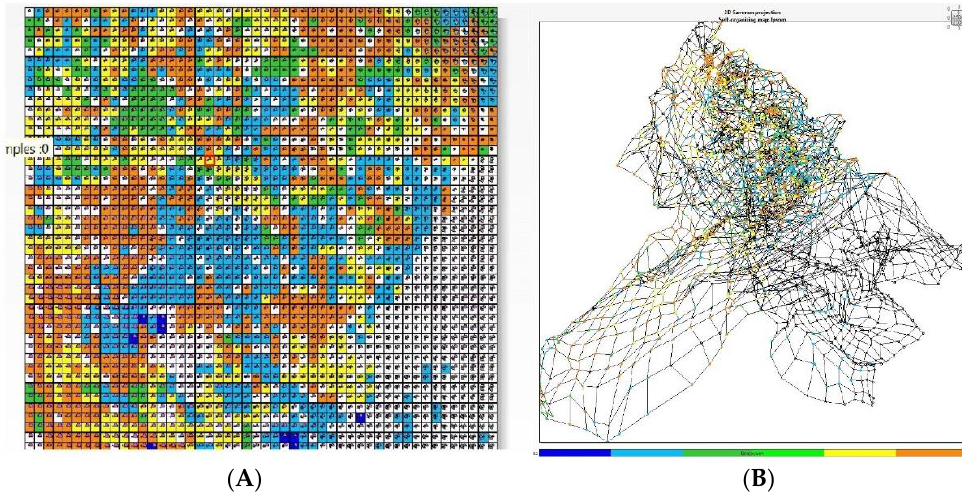
Figure 8. ( A ) IPSOM classification. ( B ) 2D Sammon projection. (b) Model Propagation